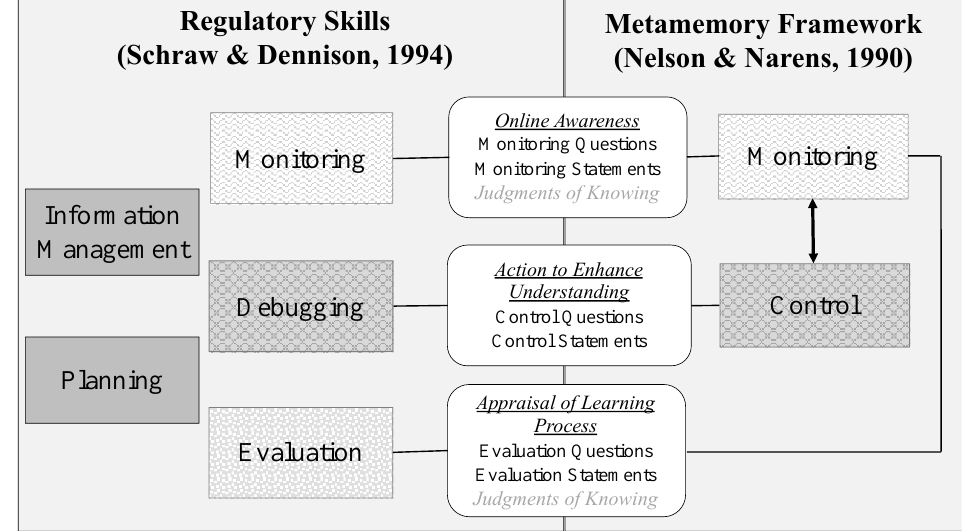
Figure 1. A comparison of the coarse-grain skills of two models that conceptualize metacognitive regulation. The gray and patterned rectangles represent the coarse-grain skills represented in each model. The rounded white rectangles connect to the coarse-grain skills that they are associated with for each of the models, highlighting the potential (mis)alignment between the constructs and measures. The rounded white rectangles also contain the definition for each of the coarse-grain skills and measures we aim to measure in this work. Note that judgments of knowing (JOKs) are shown in gray to represent the misalignment across the models with associations to evaluation for Schraw and Dennison (1994) and monitoring for Nelson and Narens (1990).